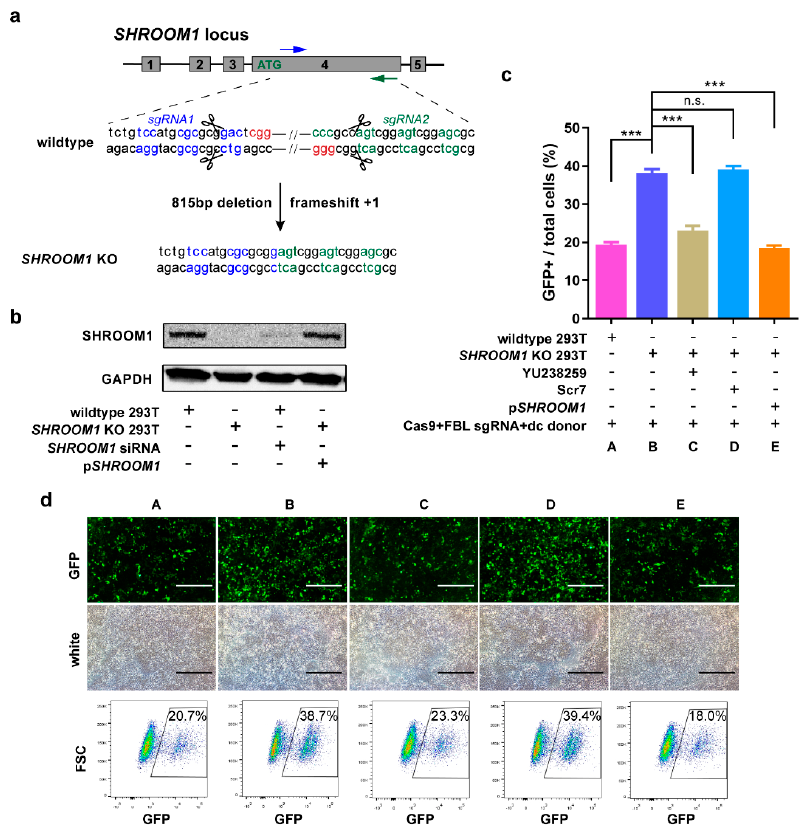
Figure 5. SHROOM1 is a potent suppressor of HDR progress. ( a ) Schematic of SHROOM1 deletion using CRISPR/Cas9 and two sgRNAs in HEK293T cells. PAM, highlighted in red; protein codon, highlighted in blue or green, KO for knockout; ( b ) Western blot of different types of cells or treatment. KO, for knockout; p SHROOM1 for SHROOM1 cDNA contained plasmid; relative knock-in efficiency ( c ) and representative visual fields and sorting charts ( d ) in SHROOM1 knockout or wild-type HEK293T cells with treatments. YU238259, an HR inhibitor; Scr7, a NHEJ inhibitor; dc, double-cut sites contained donor. Data were generated from n = 3 independent experiments. Error bars, ± SD *** p < 0.001; n.s., no significance; by two-sided Student’s t -test. Scale bar, 200 μ m.